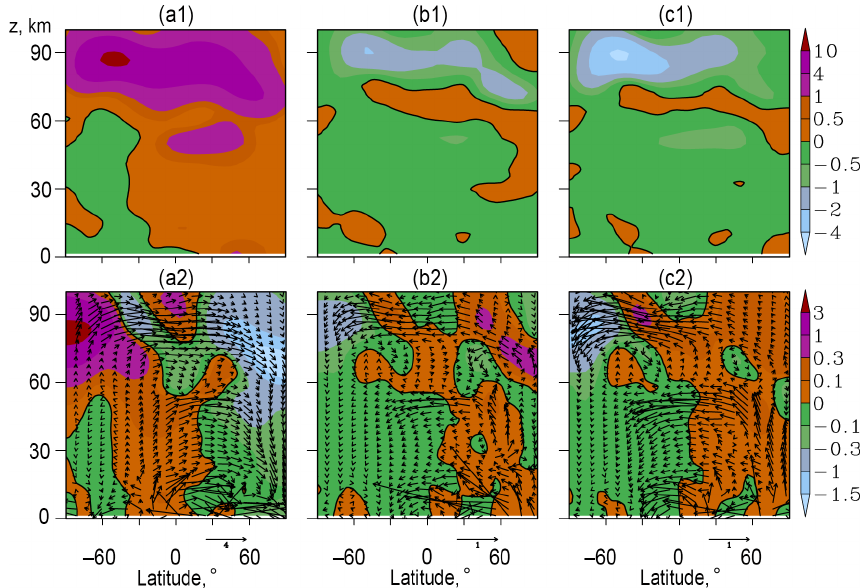
Figure 3. Zonal-mean residual meridional velocity in ms − 1 (a1) and vertical velocity in cms − 1 (a2) averaged over 19 MUAM runs for 11d intervals before the composite SSW and add-ons of respective quantities at the time intervals during SSW (b) and after SSW (c) . Arrows show vectors with components r · F ∗ x and 100 · r · F ∗ z in kgm − 2 s − 1 , which schematically represent zonal-mean RMC mass fluxes and their respective add-ons, where r = 10exp (z/ 15 ) is a scale factor used for better schematic representation at high altitudes. Solid contours correspond to zero values. All SSW events are observed in